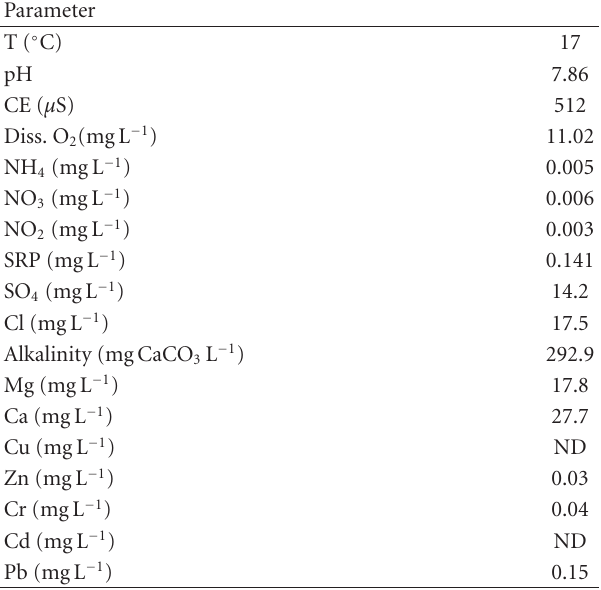
Table 1: Main chemical and physical parameters of the water where C. decemmaculatus specimens were captured (ND: not detected).